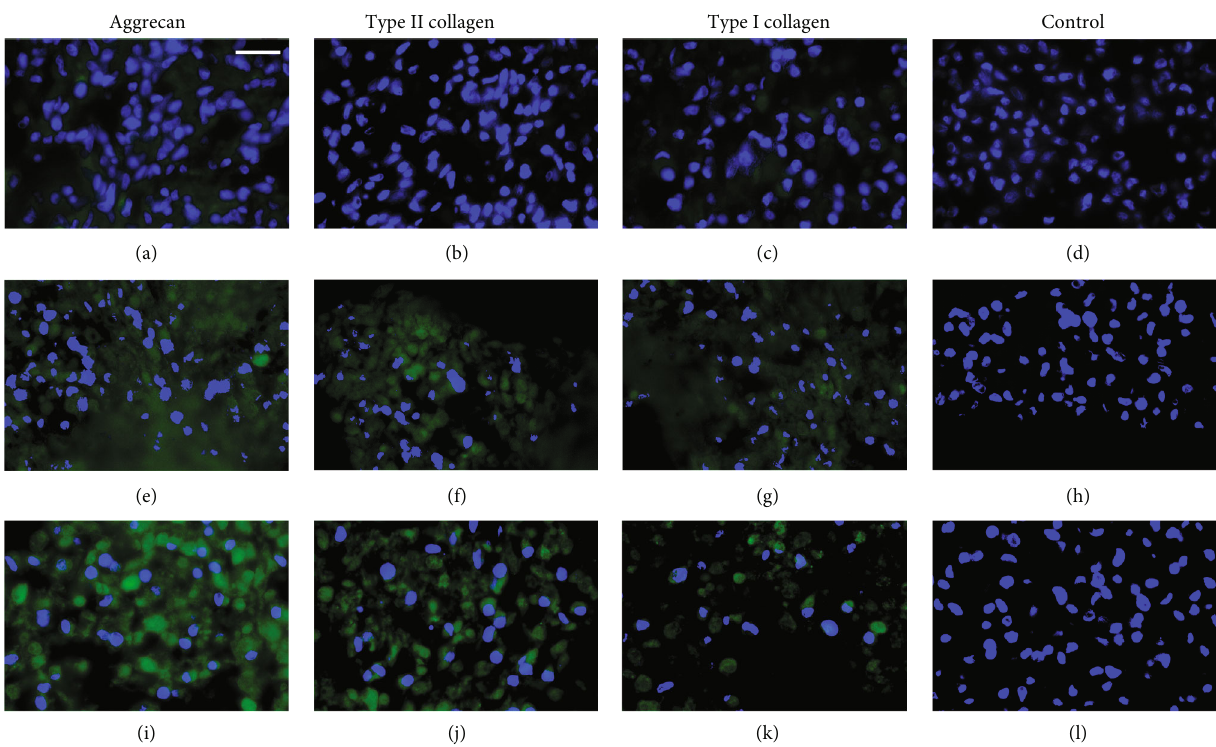
Figure 5: Immuno fl uorescence microphotographs of hDPSC microtissue cultures with chondrogenic di ff erentiation medium for (a – d) 2 weeks, (e – h) 4 weeks, and (i – l) 6 weeks. Control samples were incubated only with the secondary antibody. Cellular nuclei are observed in blue, and the presence of the di ff erent speci fi c macromolecules was analysed in green. To facilitate the visualization of the fl uorescence signal, green channel parameters of some images were modi fi ed by PhotoShop: (a, c) saturation + 100 % and luminosity + 50 % and (e – g) saturation + 100 % and luminosity + 25 % . Scale bar = 25 μ m